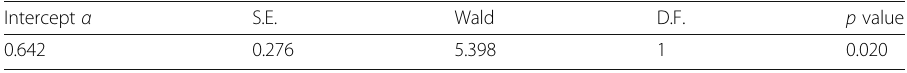
Table 9 The intercept-only model attributes